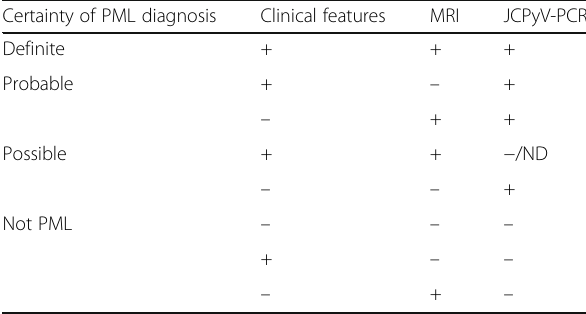
Table 11 Diagnostic criteria for PML (according to [20]) Certainty of PML diagnosis